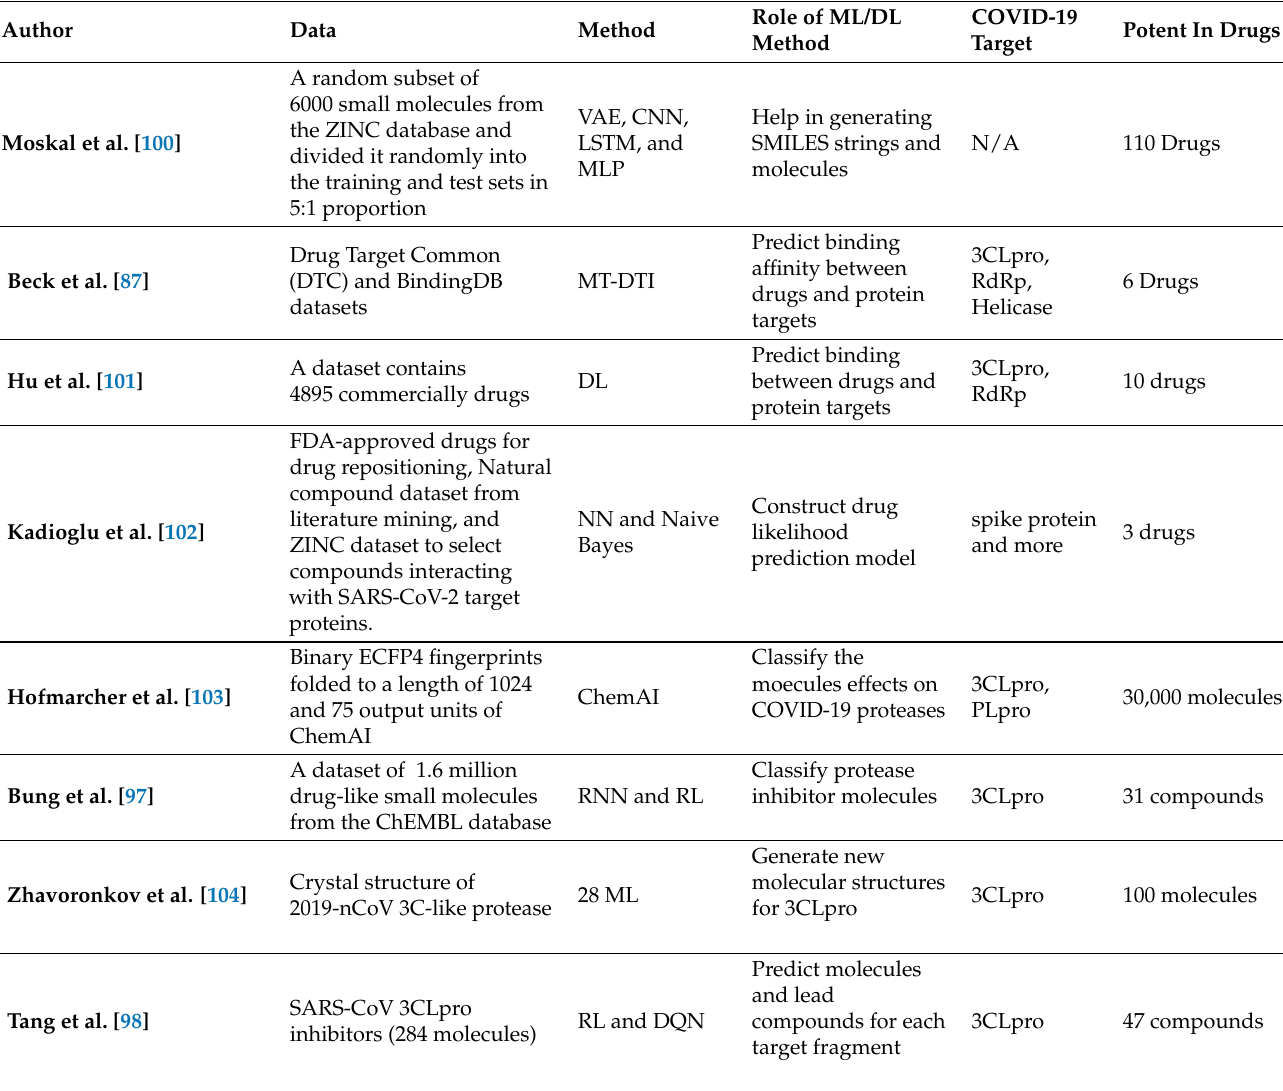
Table 4. A summary of drug development of COVID-19 based on AI-based ML and DL methods